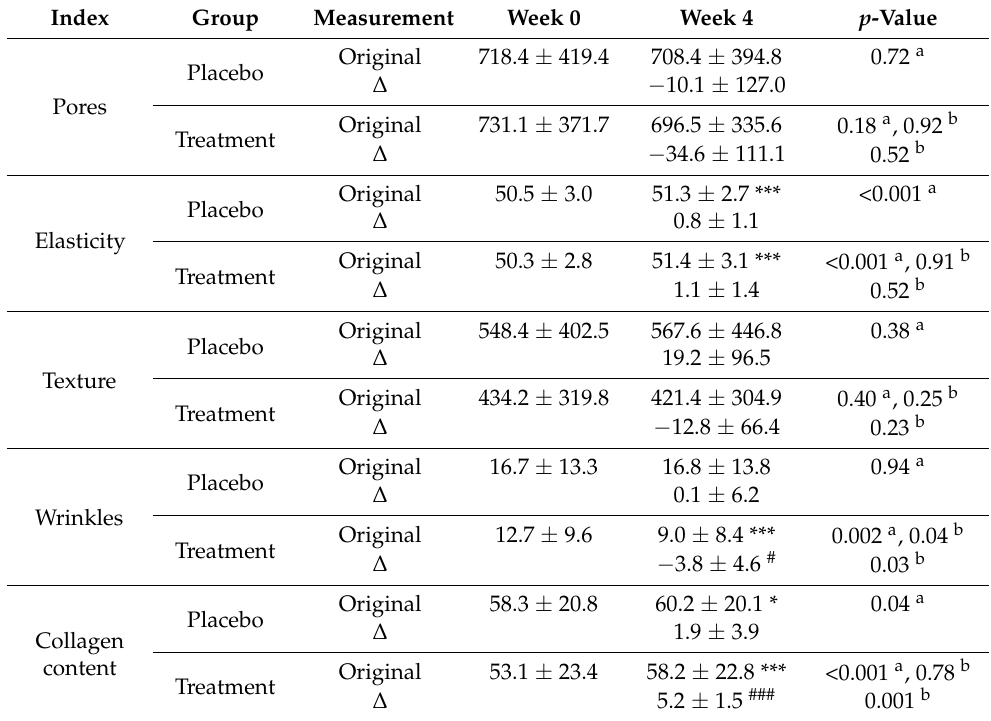
Table 2. Measurement of collagen-related factors in the subjects (mean value ±